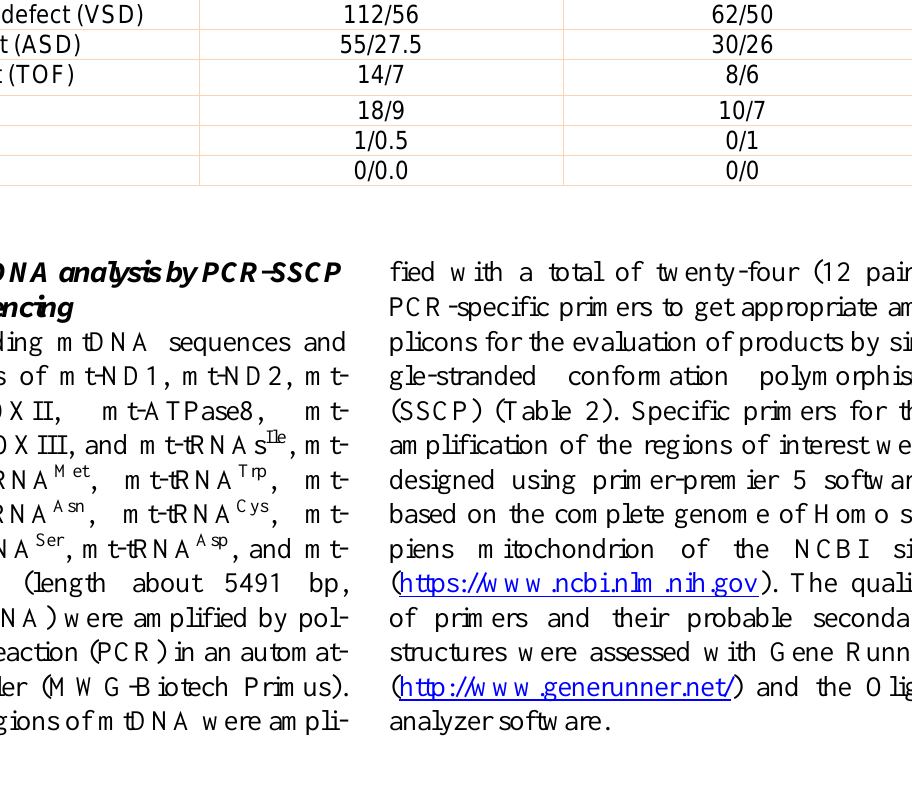
Table 2: Specific primer sequences used for analysis of selected mitochondrial